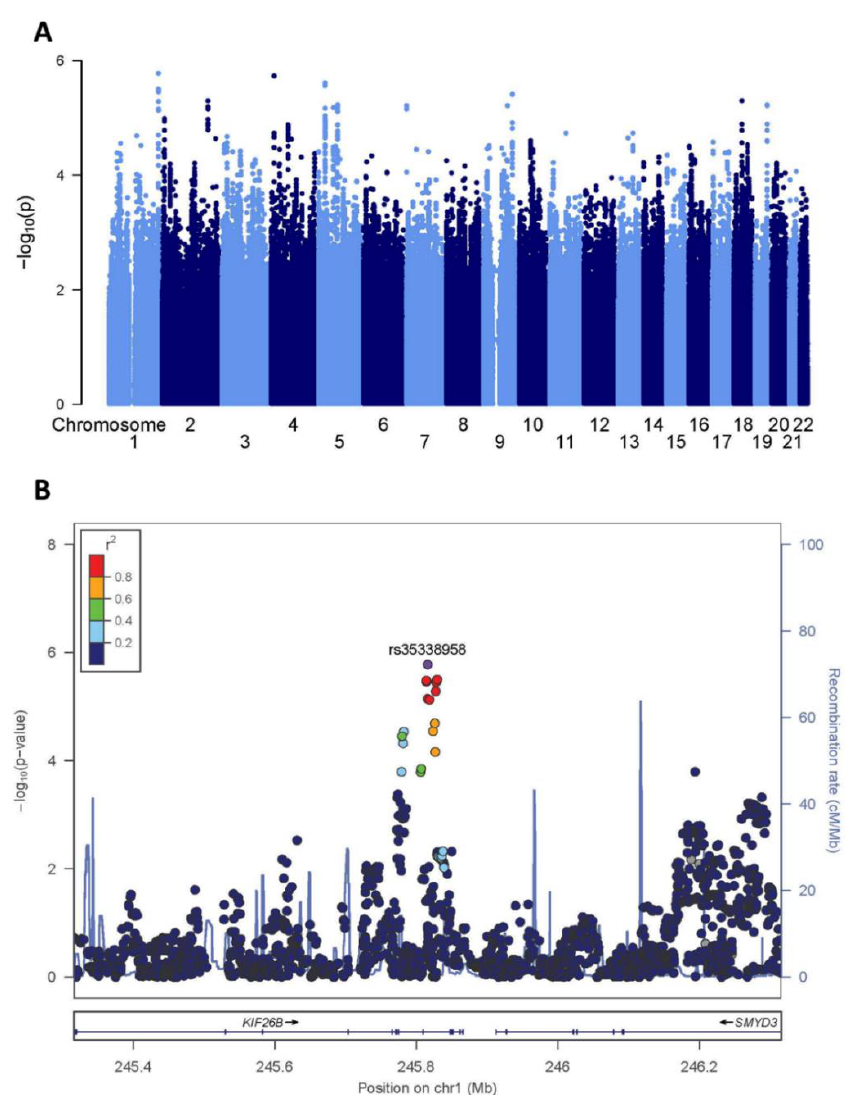
Figure 1. Screening genome-wide association analysis for HO severity-associated variants. ( A ) Man- hattan plot showing the − log10 p -values for each variant ( y axis) plotted against their respective chromosomal position ( x axis). The horizontal dashed line denotes the genome-wide significance threshold p = 5 × 10 −8 . ( B ) Regional association plot of the KIF26B variant association with HO severity. Each filled circle represents the p -value of analyzed variants in the discovery stage plotted against their physical position (NCBI Build 37). The purple circle denotes rs35338958, which is the variant with the lowest p -value in the region. The colors of variants in each plot indicate their r 2 with the lead variant according to a scale from r 2 = 0 (blue) to r 2 = 1 (red).